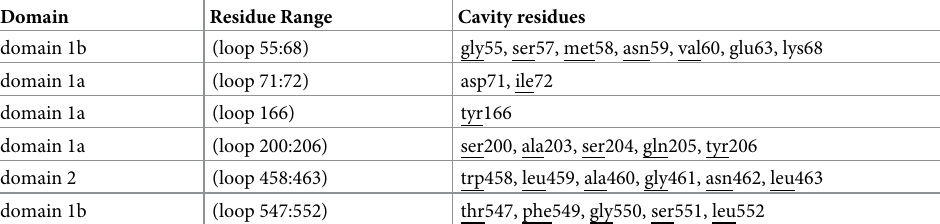
Table 2. Residues in the putative ligand-binding cavity. Neutral or hydrophobic residues are